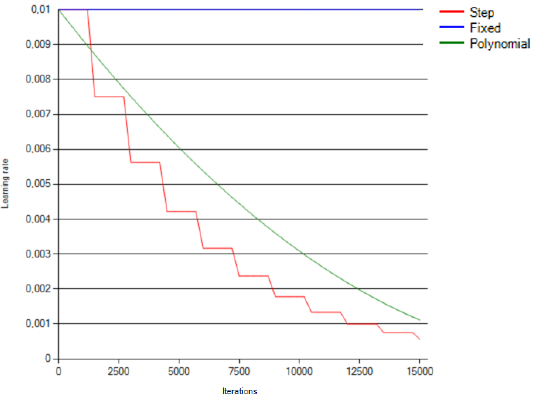
Figure 7. Learning rate over iterations based on the same learning rate functions as those in Figure